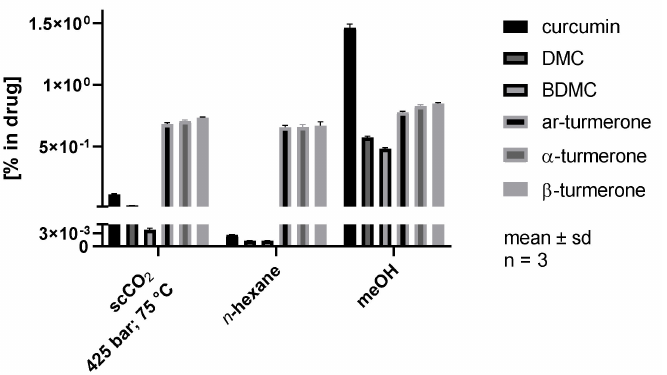
Figure 6. Comparison of a scCO 2 extract characterized by maximum curcumin and ar-turmerone yields with n -hexane and methanol extracts.